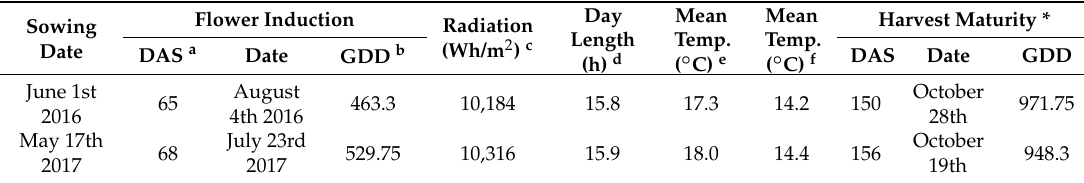
Table 2. Sowing dates, accumulated growing degree-days (GDD), radiation, day length and mean temperatures at Ihinger Hof in 2016 and